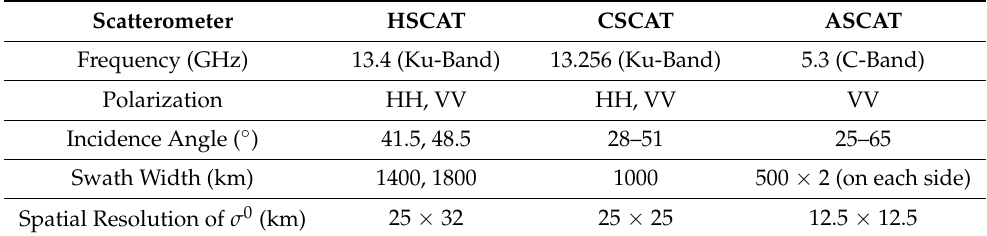
Table 1. Information regarding the three scatterometers used in this study. Scatterometer HSCAT CSCAT ASCAT Frequency